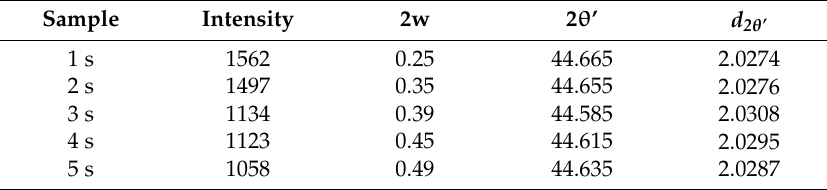
Table 2. Diffraction peak width at maximum height (FWHM parameter).